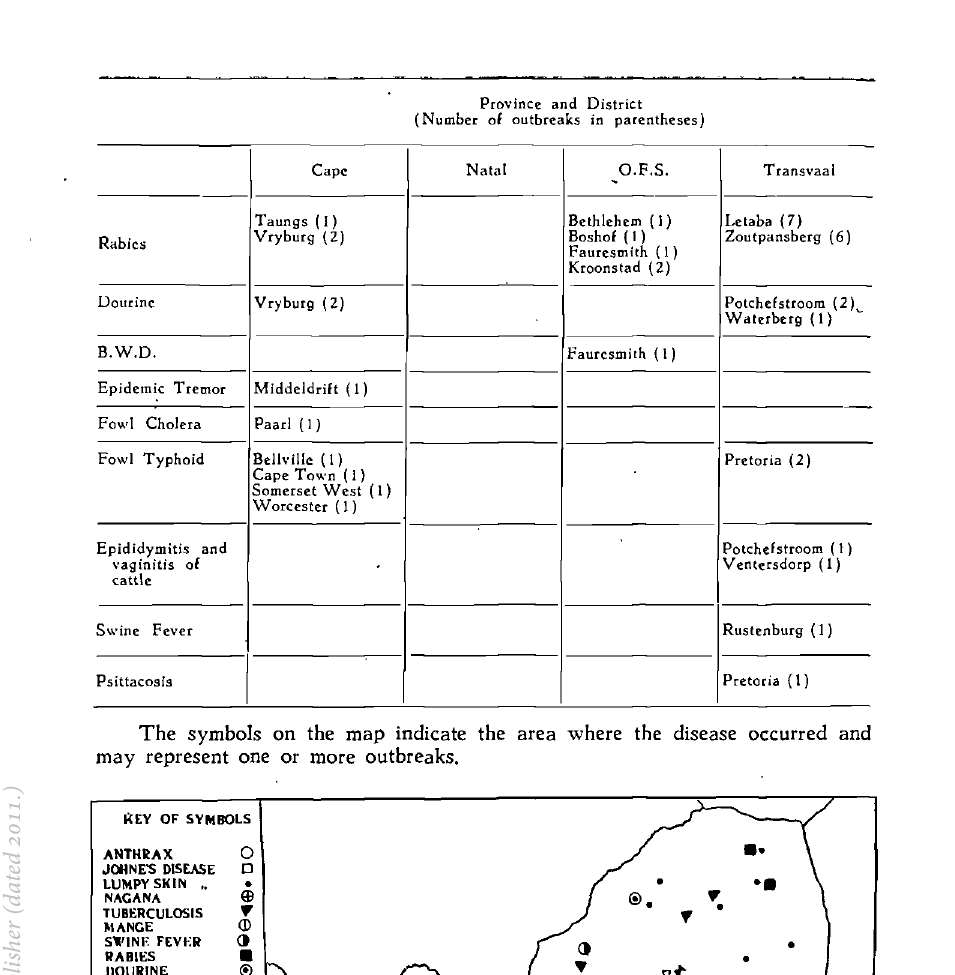
The symbols on the map indicate the area where the disease occurred and may represent one or more